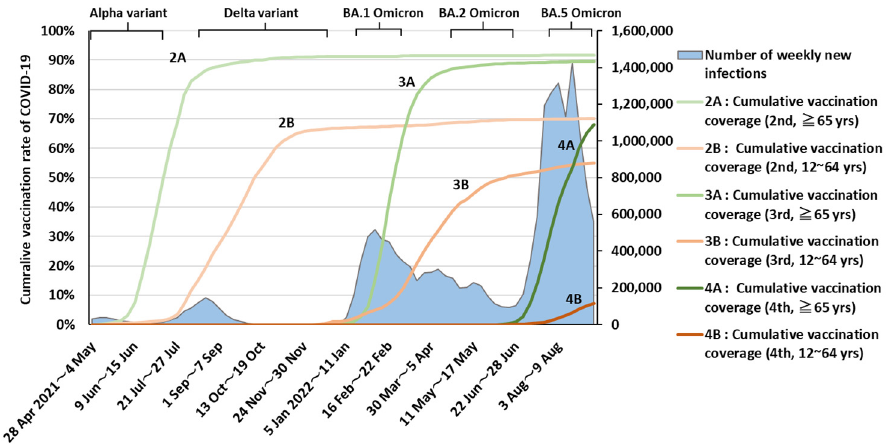
Figure 1. Trends in cumulative vaccination coverage and number of weekly new instances of COVID-19 in Japan. Data on the number of weekly new infections were obtained from the Ministry of Health, Labour and Welfare. Cumulative vaccination rate data were obtained from the Prime Minister’s Office of Japan [20]. Graph indicates dominant period ( ≧ 85%).